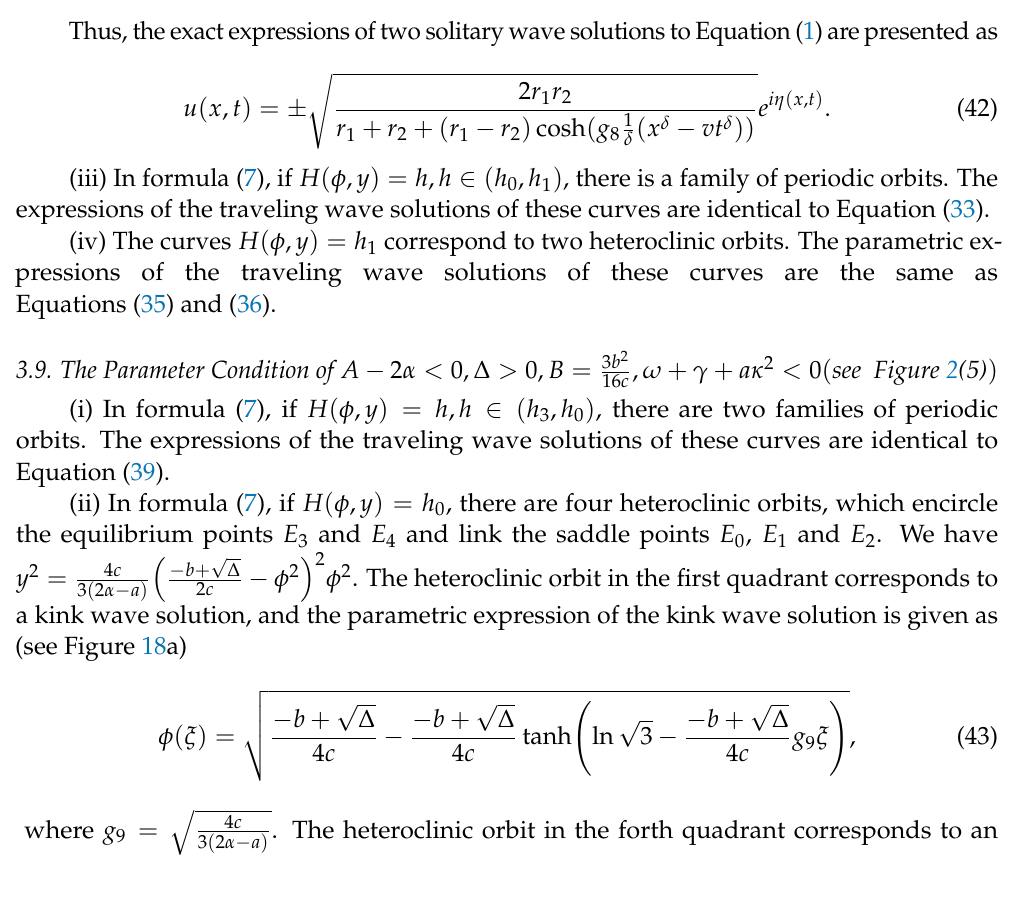
Figure 17. Solitary wave forms of system (5). ( a ) Bright solitary wave derived by Equation (41) + . ( b ) Dark solitary wave derived by Equation (41) −